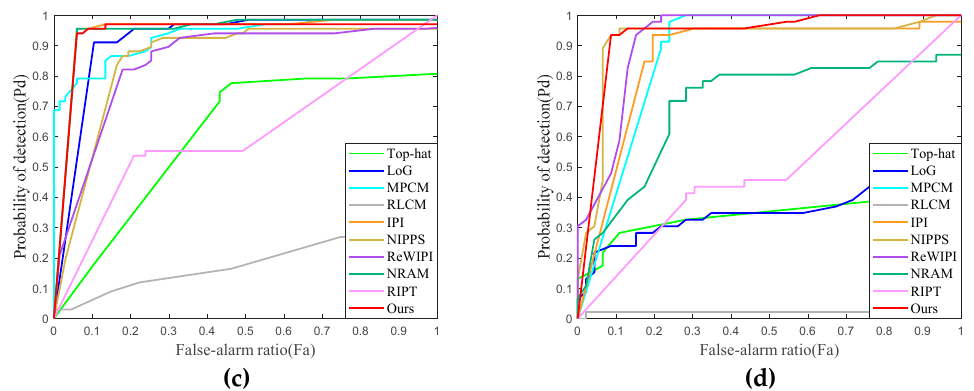
Figure 19. ROC curves of detection results of four real sequences. ( a ) Sequence 1; ( b ) Sequence 2; ( c ) Sequence 3; ( d ) Sequence 4. Table 6. Area under curve (AUC) values of the 10 methods.